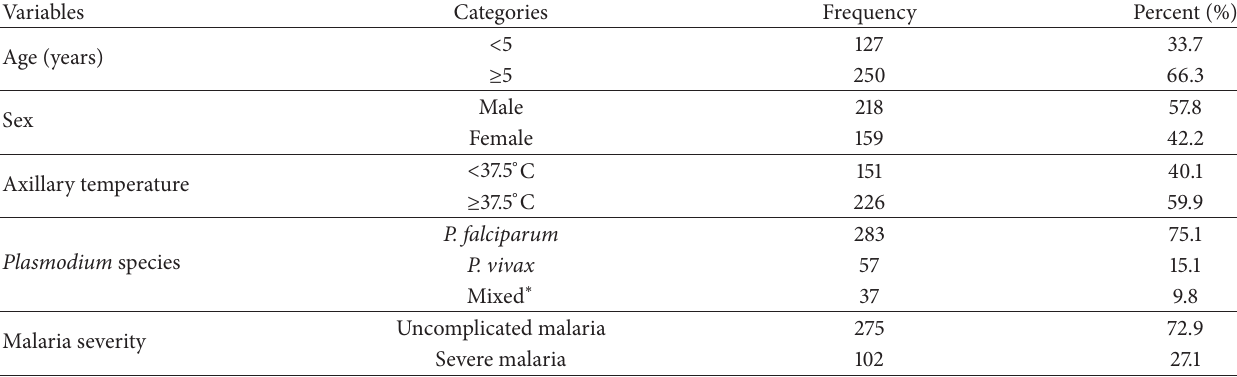
Table 1: Demographic and clinical characteristics of the study participants, Pawe General Hospital, 2014.